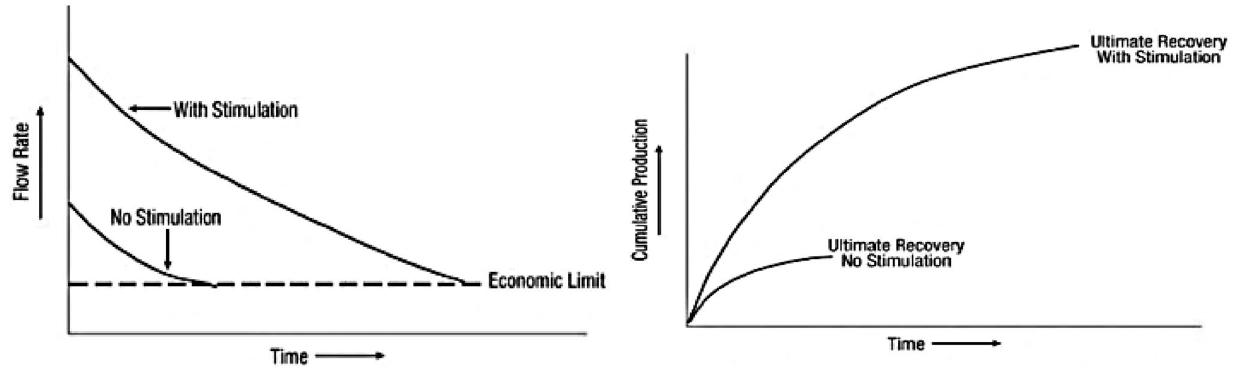
Fig. 2 The concept of production and reserves enhancement from hydraulic fracture, low-permeability reservoirs ( Holditch 2006